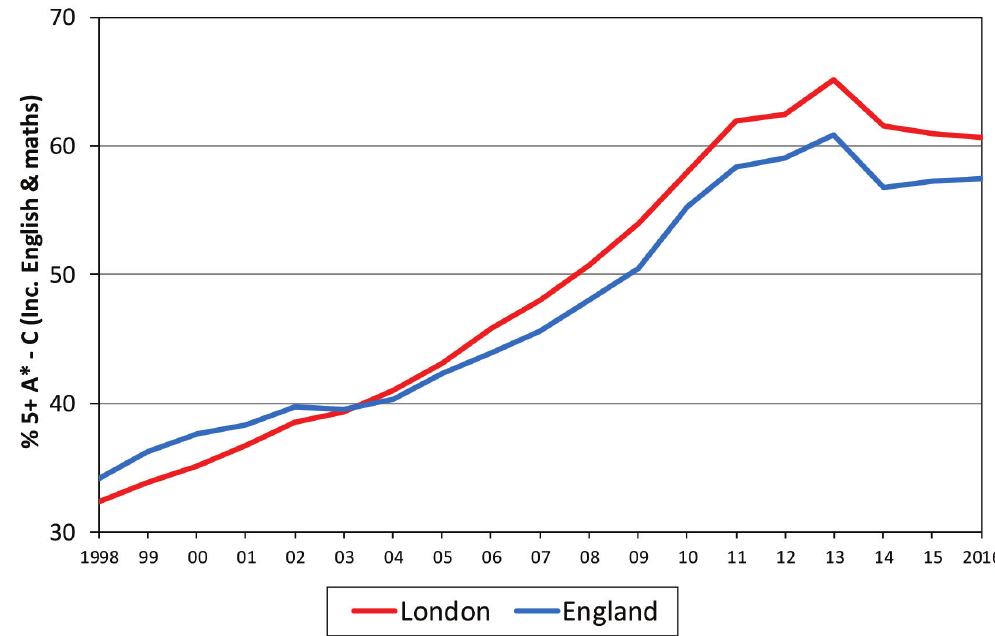
Figure 2: Key Stage 4, percentage 5+ A*–C including English and mathematics, 1998–2016: London and national (DfE Key Stage 4 school performance tables, 1998 to